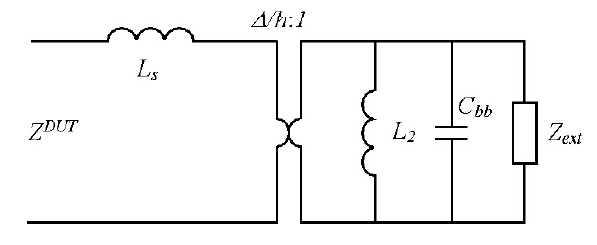
FIG. 2. Equivalent circuit for Z DUT .